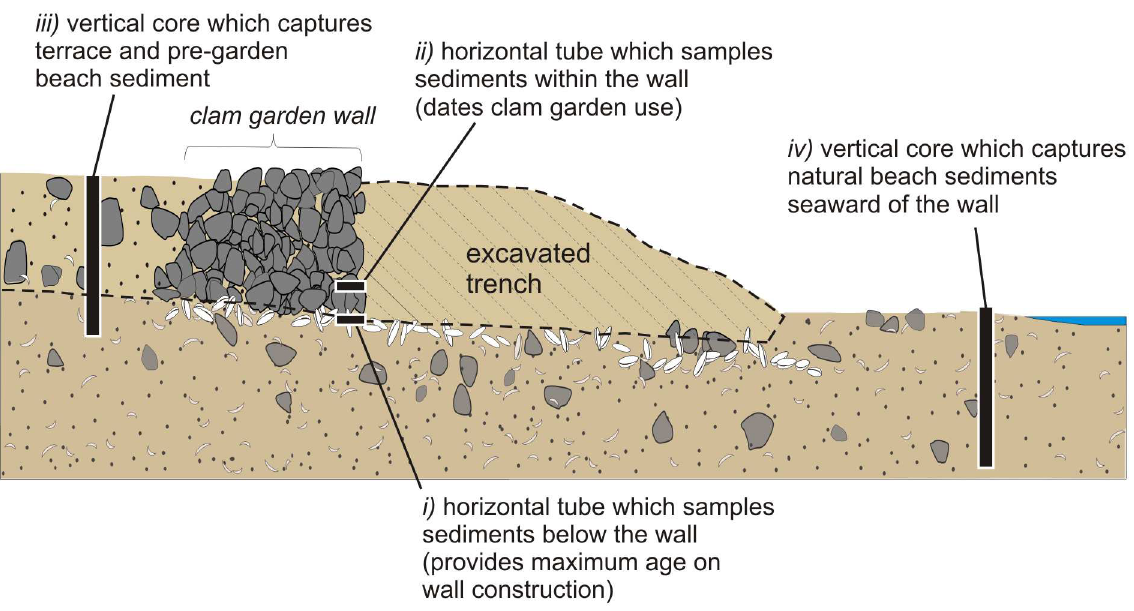
Fig 5. A conceptual diagram illustrating the sampling strategy for optical dating clam gardens. All methods ( i–iv ) were appliedat site KB14-05 (SingleWall Site) whileone method ( i ) was appliedat sites EbSh-5 (DoubleWall Site) and EbSh-58 (Triple Wall Site). Not drawn to